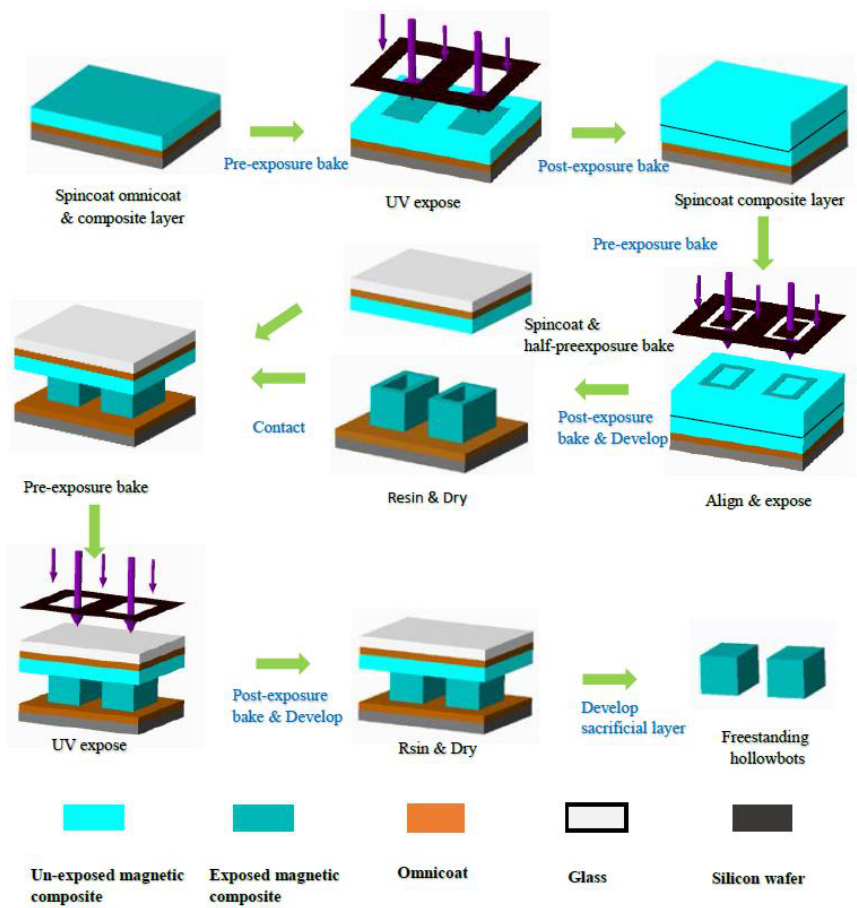
Figure 2. Schematic of magnetic hollowbots fabrication.